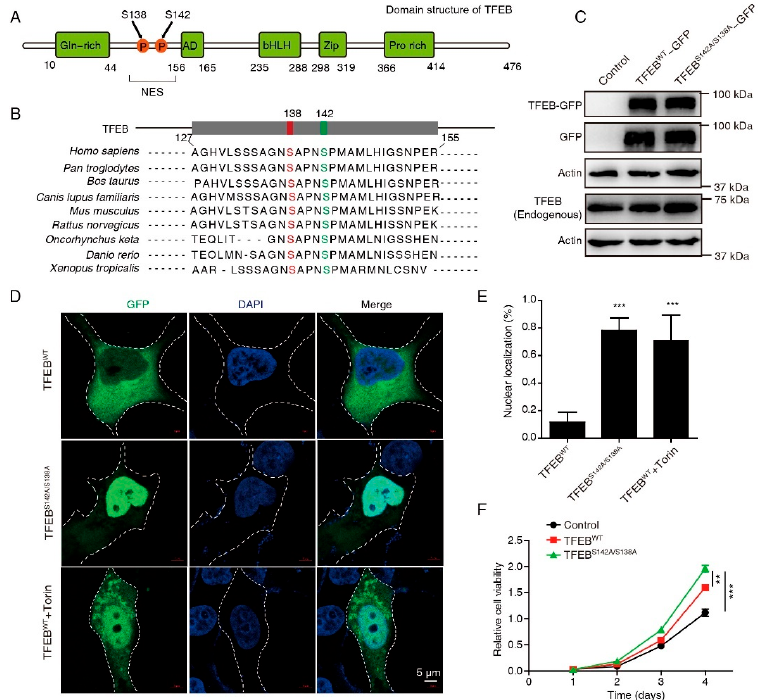
Figure 1. Mutations in S138 and S142 caused almost complete nuclear retention of TFEB. ( A ) Schematic of the human TFEB protein domains. S138 and S142 are localized in the proximity of a NES. ( B ) S138 and S142 of TFEB are evolutionarily conserved in the indicated species. Alignment of the sequences near TFEB S138 and S142 is shown. ( C ) Western blots of endogenous and exogenous TFEB in CRC cells transfected with wild-type TFEB-GFP or TFEB-GFP mutant (S142A/S138A). Uncropped immunoblots are provided in the Figure S1. ( D , E ) Localization of TFEB WT and TFEB S142A/S138A in the cytosol and in the nucleus was detected by confocal microscopy. Representative images ( D ) and statistical results ( E ) are shown. Torin1 (250 nm), a positive control. Cell outlines in white dotted lines. DAPI was used to label the nucleus. Scale bars, 5 μ m. Mean ± SD, n = 10 cells per condition, unpaired t -test. ( F ) Cell viability of indicated cells were analyzed using a CCK8 assay. Mean ± SEM, n = 3, unpaired t -test. ** p < 0.01, *** p < 0.001.